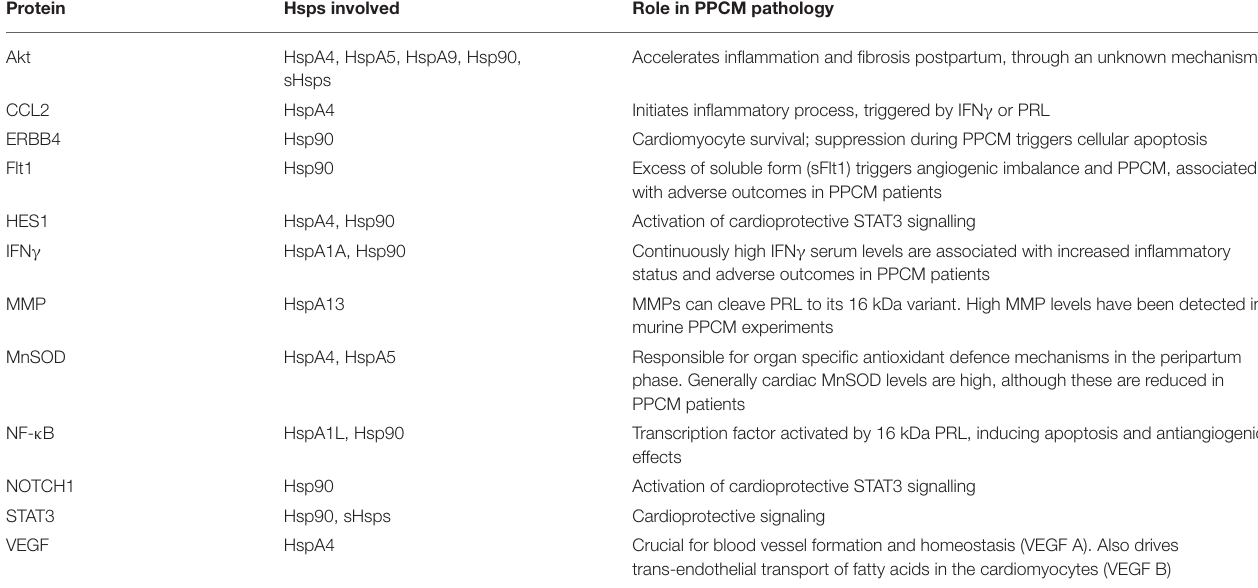
TABLE 2 | STRING interactions between heat shock and PPCM proteins.